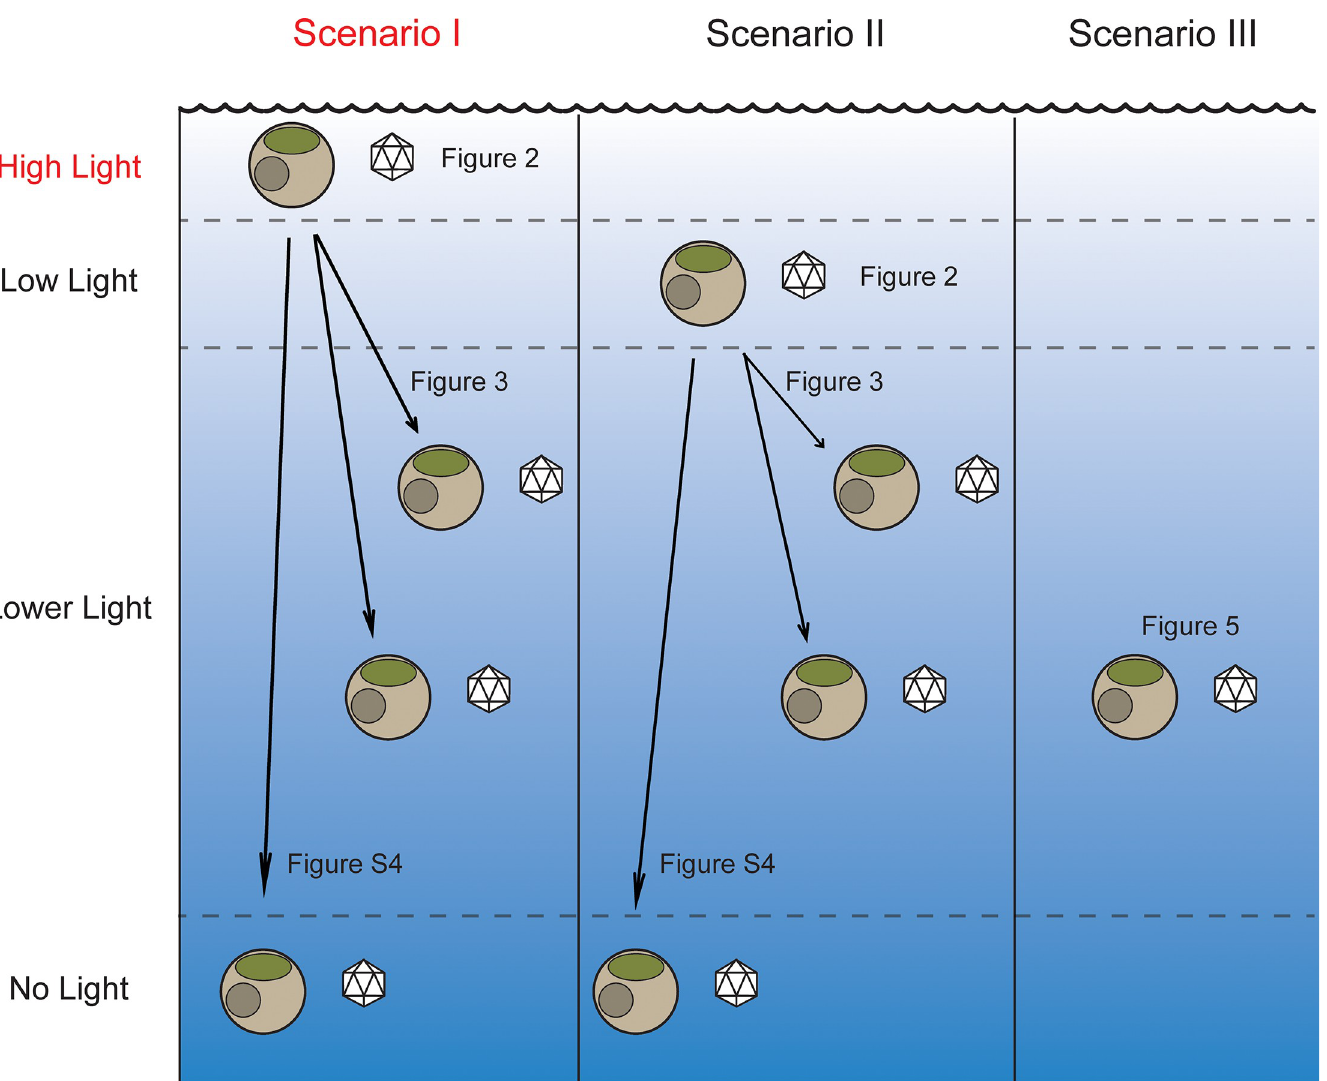
Fig 7. Ecological predictions of Aureococcus AaV interactions over the course of a bloom and effects of sinking. High light corresponds to 90 μ mol photons m -2 s -1 , low light corresponds to 30 μ mol photons m -2 s -1 , lower light corresponds to 15 and 5 μ mol photons m -2 s -1 .